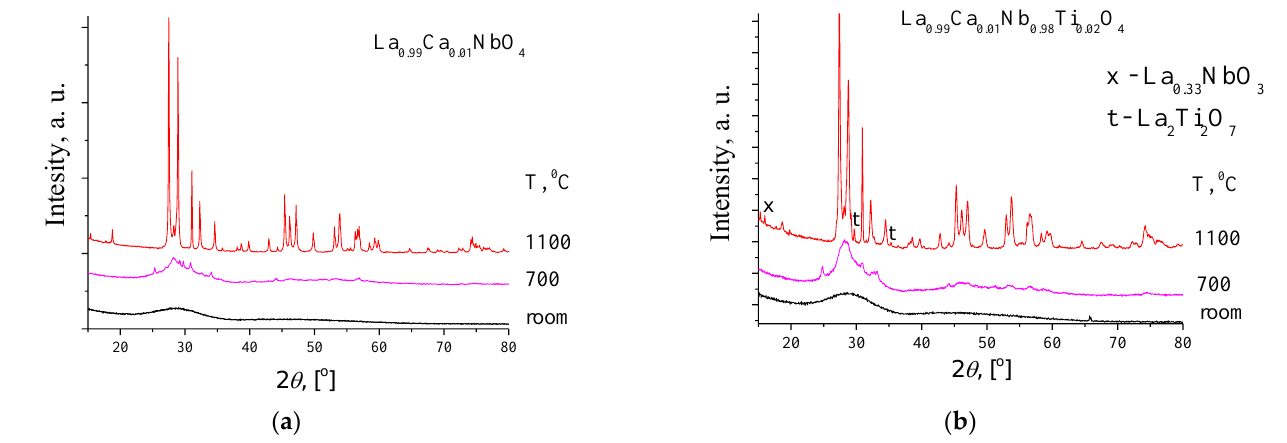
Figure 1. XRD patterns of ( a ) LCNb and ( b ) LCNbTi sintered at different temperatures. In contrast, the powder of La 0.99 Ca 0.01 Nb 0.98 Ti 0.02 O 4 –δ (LCNbTi) calcined at 1100 °C is a mixture of three phases — monoclinic LaNbO 4 –δ (PDF [01-083-1911]) and low quantities of monoclinic La 2 Ti 2 O 7 (PDF [00-028-0517] and orthorhombic La 0.33 NbO 3 (PDF [00-026-0822]) phases (Figure 2b). The impurity La 0.33 NbO 3 is a mixed electronic and ionic (oxygen-ion and proton) conductor depending on temperature and conditions [44]. The presence of this impurity can also lead to an increase in the proton conductivity.